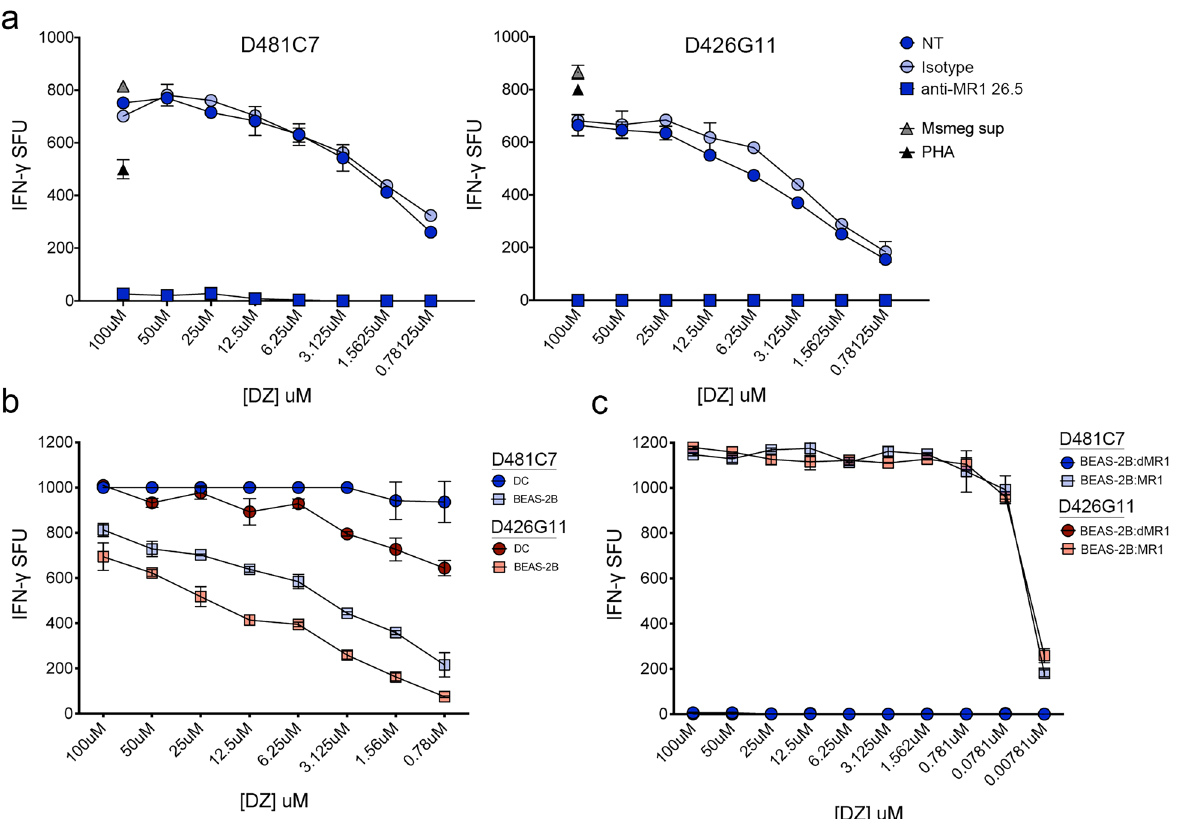
Figure 5. MR1T cell recognition of DZ is MR1-dependent. ( a ) The IFN-γ response by 2 × 10 4 D481C7 or D426G11 T cells was measured in an ELISPOT assay with 1 × 10 4 DC pulsed with DZ at the indicated concentration. Where indicated, the α-MR1 26.5 antibody or isotype control was added one hour prior to adding DZ to the wells. PHA and supernatant from M. smegmatis were used as described as positive controls for the assay. ( b ) The IFN-γ response by D481C7 or D426G11 was measured in an ELISPOT assay with 1 × 10 4 DC or 1 × 10 4 wild-type BEAS-2B cells pulsed with DZ at the indicated concentration. ( c ) The IFN-γ response by D481C7 or D426G11 was measured in an ELISPOT assay with 1 × 10 4 BEAS-2B:ΔMR1 or BEAS- 2B:ΔMR1 + MR1 cells pulsed with DZ at the indicated concentration. Error bars indicate the standard deviation of technical replicates. Data shown are representative of 3 independent experiments.